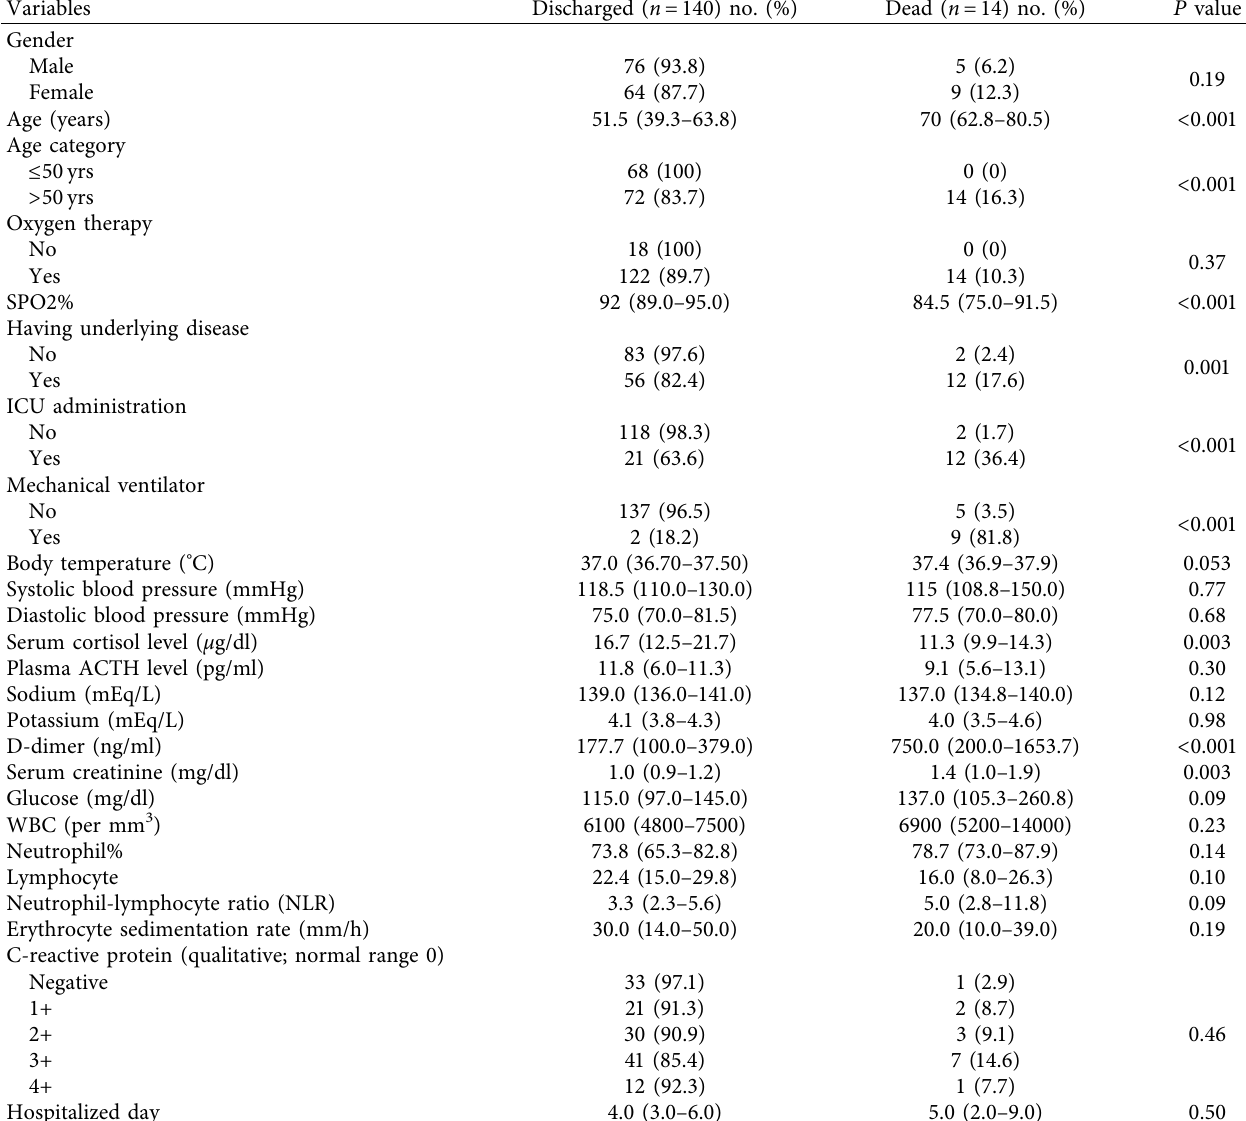
Table 2: Comparison of demographic and clinical variables between discharged and expired patients.